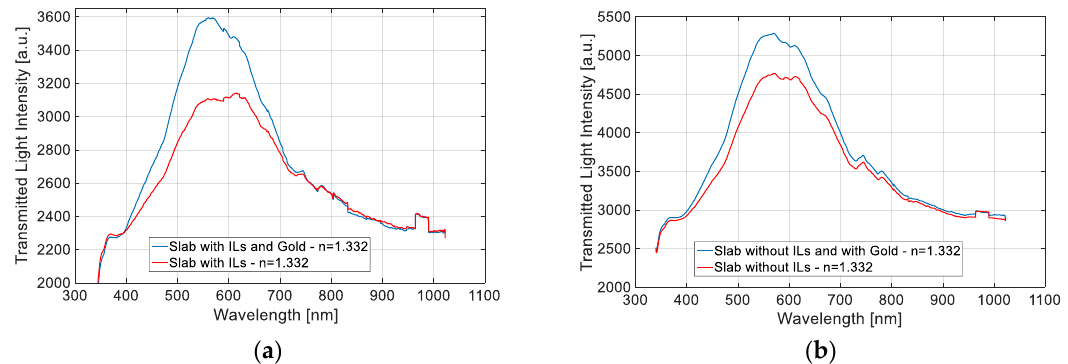
Figure 7. Transmitted spectra in water ( n = 1.332) obtained before the normalization: ( a ) Slab with ILs. ( b ) Slab without ILs.